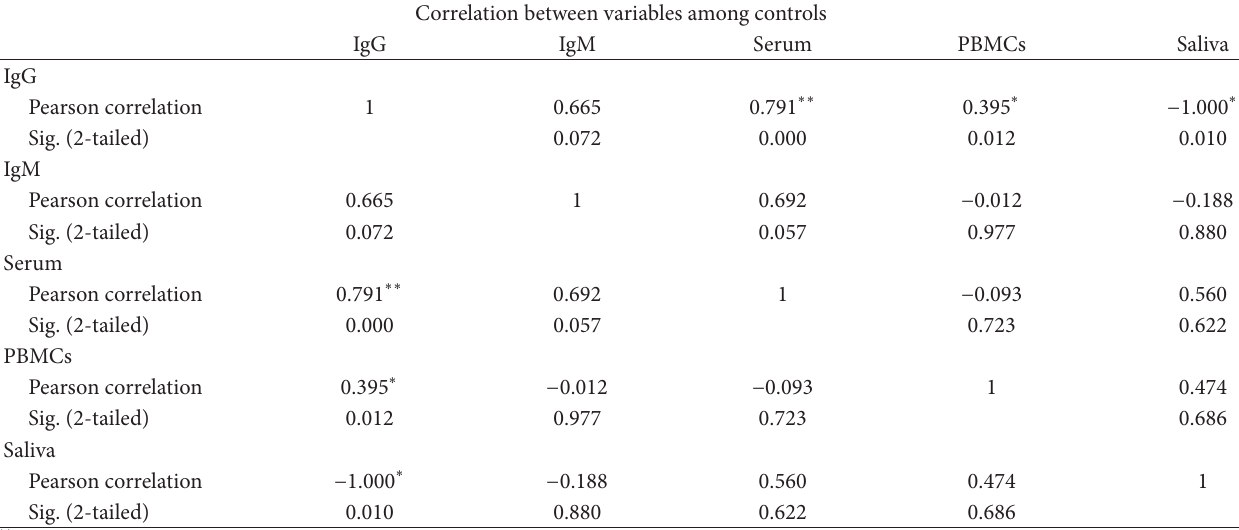
T 4: Correlation of HHV-6-DNA detection in separate specimens (HHV-6 + ) with HHV-6 seroprevalence (IgG and IgM) in healthy